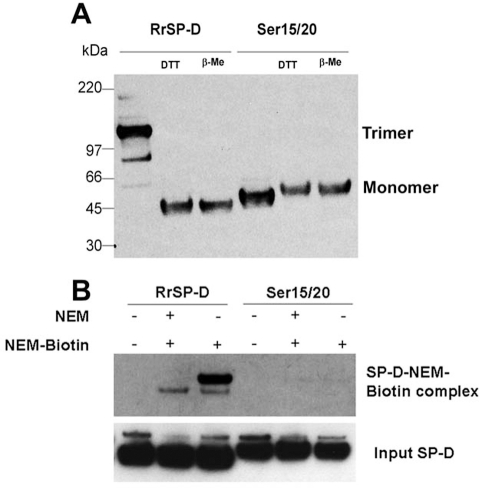
Role of Cysteine Residues 15 and 20 in Formation of SP-D Trimers(A) Recombinant rat SP-D (RrSP-D) or a mutant in which cysteines 15 and 20 have been mutated to serine (Ser15/20) were denatured under reducing (using mercaptoehtanol or dithiothreitol as the reductant) and non-reducing conditions. The resultant proteins were analyzed by SDS-PAGE and Western blotting with SP-D antibody.(B) RrSP-D and Ser15/20 were pre-incubated with NEM-linked to biotin at 37 °C for half an hour either with or without prior incubation with unlinked NEM. Biotin-labeling was determined by Western blotting following SDS-PAGE with anti-biotin antibody.